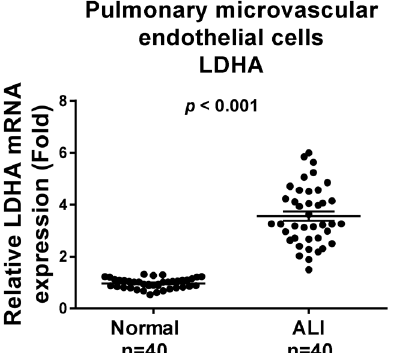
Figure A3: Expression of LHDA in ALI. Primary human pulmonary microvascular endothelial cells from patient lung tissues ( n = 40 ) and healthy controls were isolated and the expressions of LDHA were analyzed by qRT -